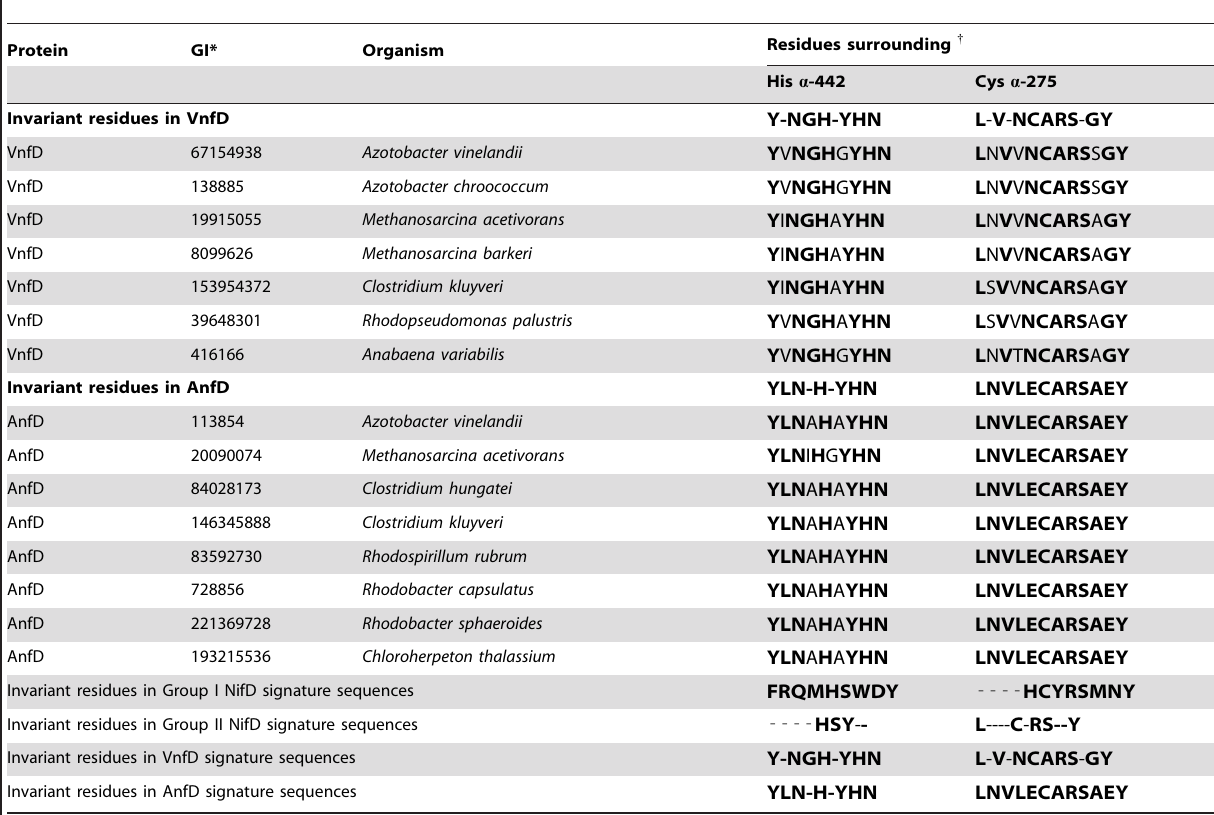
Table 4. Conserved residue patterns in nitrogenase VFe a subunit (VnfD), and nitrogenase FeFe a subunit (AnfD), and comparison with the corresponding patterns in Group I and II NifDs.